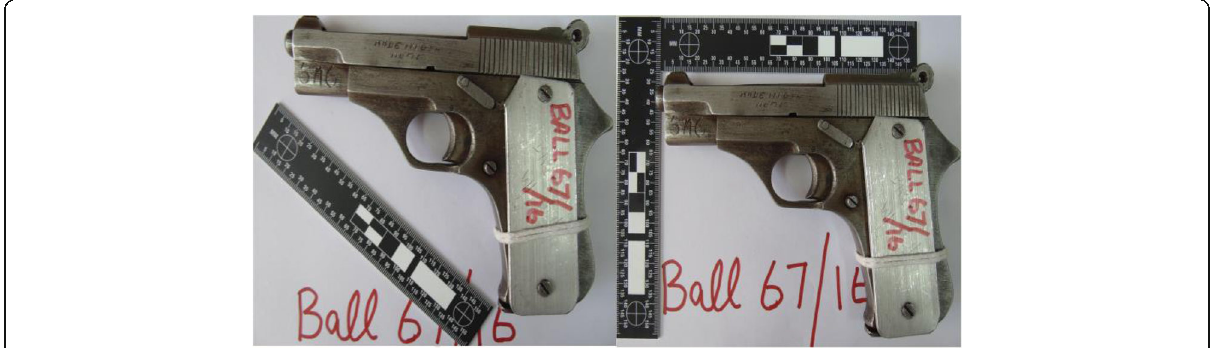
Fig. 1 Showing dimension of country made pistol (India)